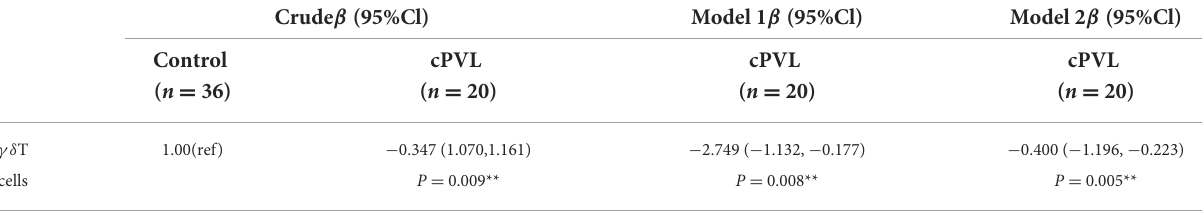
TABLE 2 Multivariate linear logistic regression model compares the γδ T ratio between cPVL and